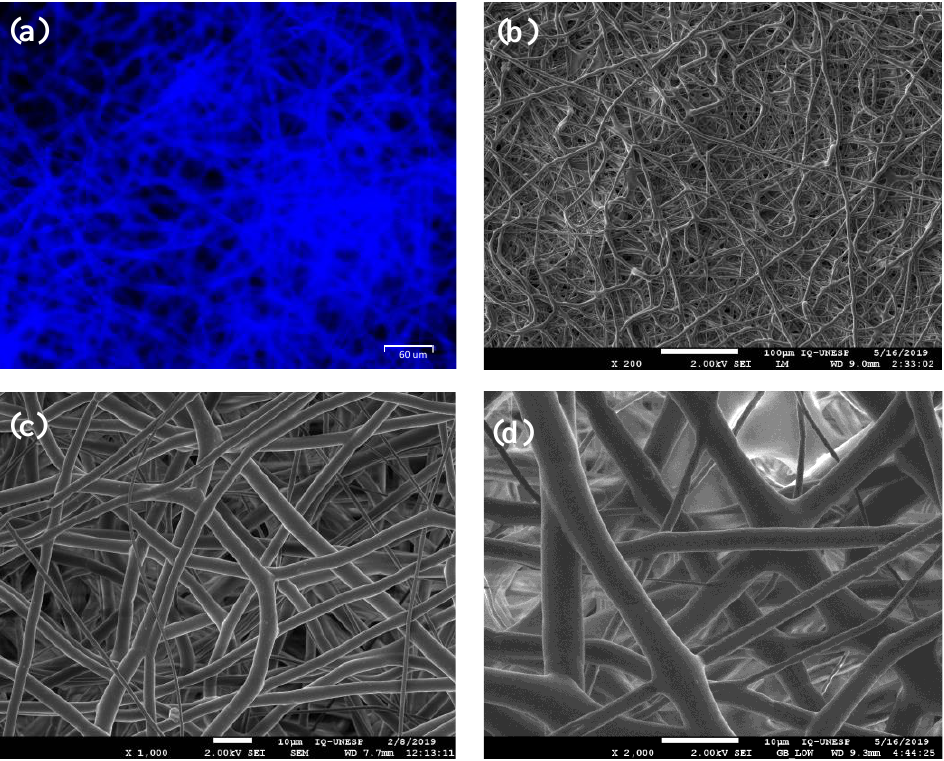
Figure 1. Morphological analysis of the PDO membranes. ( a ) Fluorescence microscopy using Hoechst dye. SEM images at ( b ) 200×, ( c ) 1000×, and ( d ) 2000× magnification.